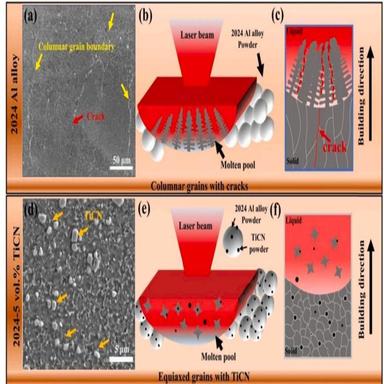
Schematic diagram of the microstructures and solidification mechanisms for (a–c) pure 2024 Al alloy, and (d–f) 2024-5 vol% TiCN composite.